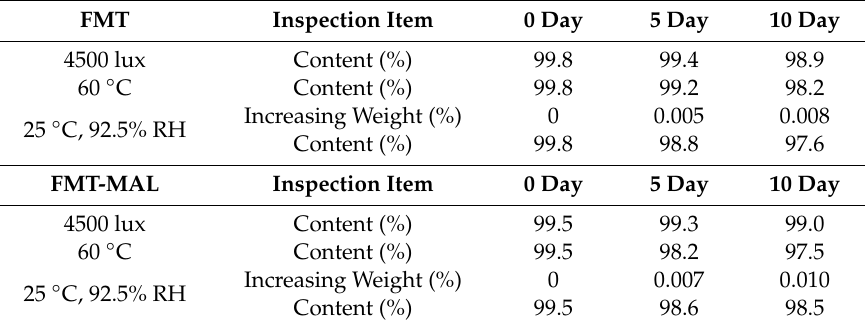
Table 4. Stability data at 60 °C, 25 °C/92.5% RH, and 4500 lux conditions.